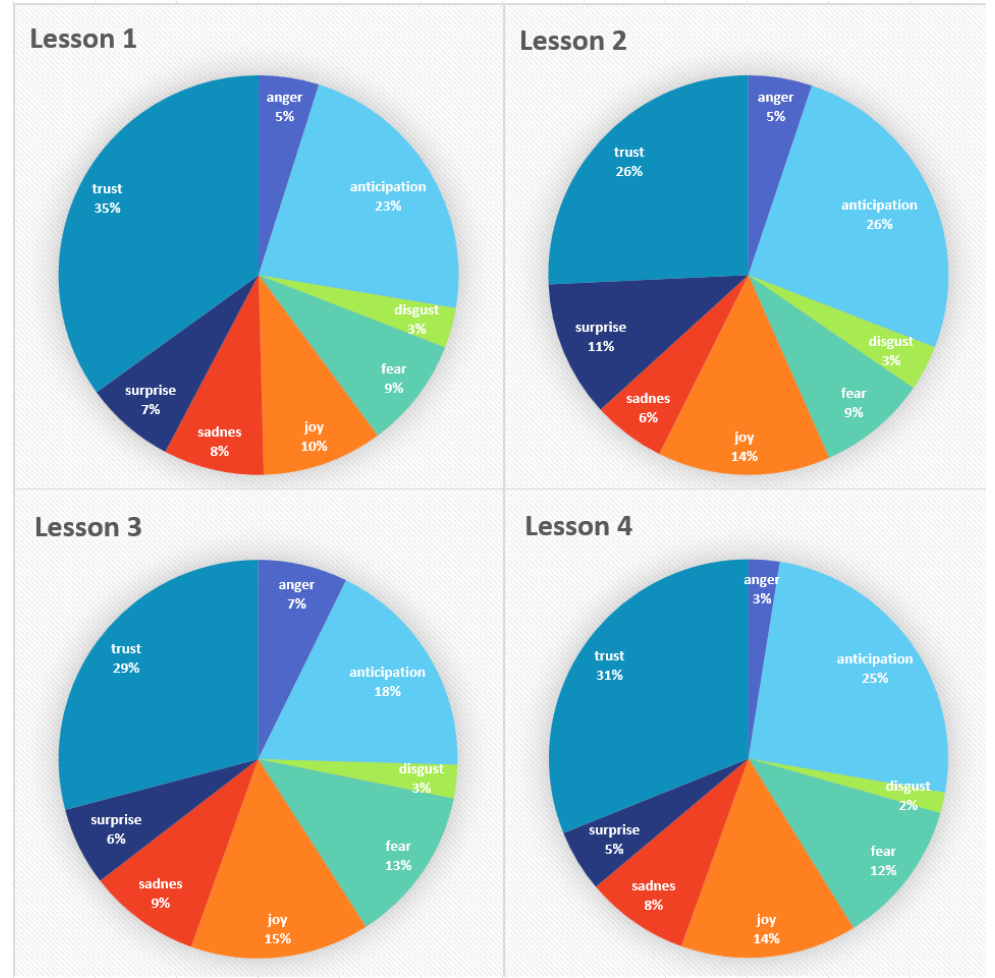
Figure 8. Frequency of emotions detection in each lesson. Table 4. Number of students who expressed each